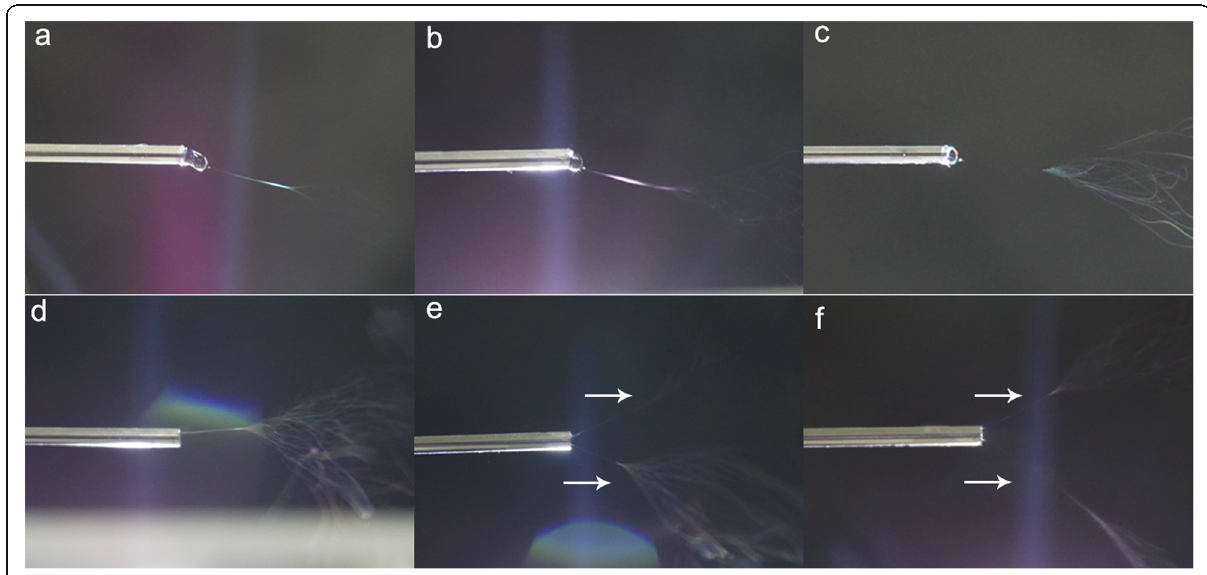
Fig. 5 The optical images of jet evolution in spinning process under different voltage value a 6 kV, b 10 kV, c 15 kV, d 20 kV, e 25 kV, and f 30 kV (the inner diameter of spinneret is 0.8 mm, outer diameter of spinneret is 1.2